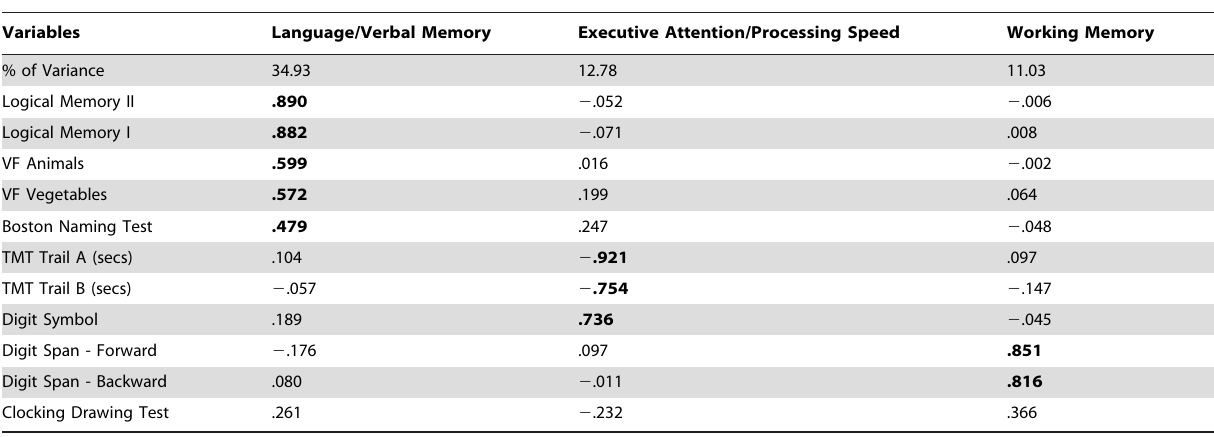
Table 2. Results of the Principal Components Factor Analysis at Year One.